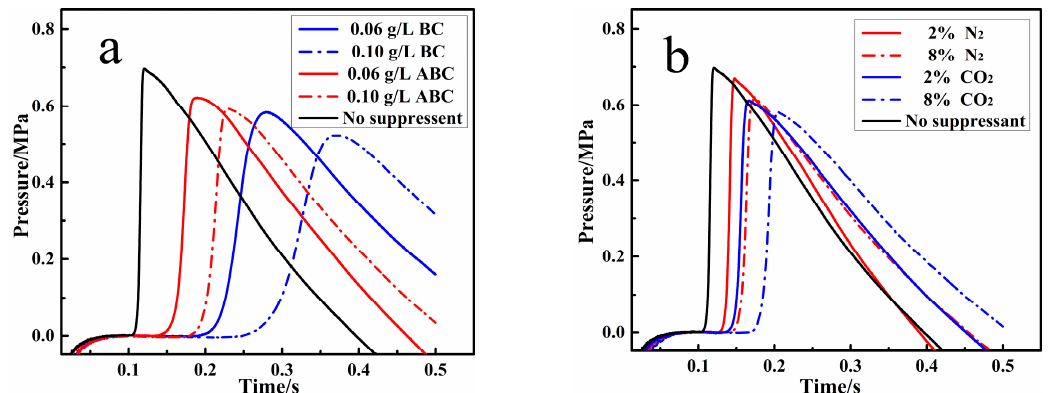
Figure 2. Pressure–time curves of methane explosion under single-phase inhibitors: ( a ) NaHCO 3